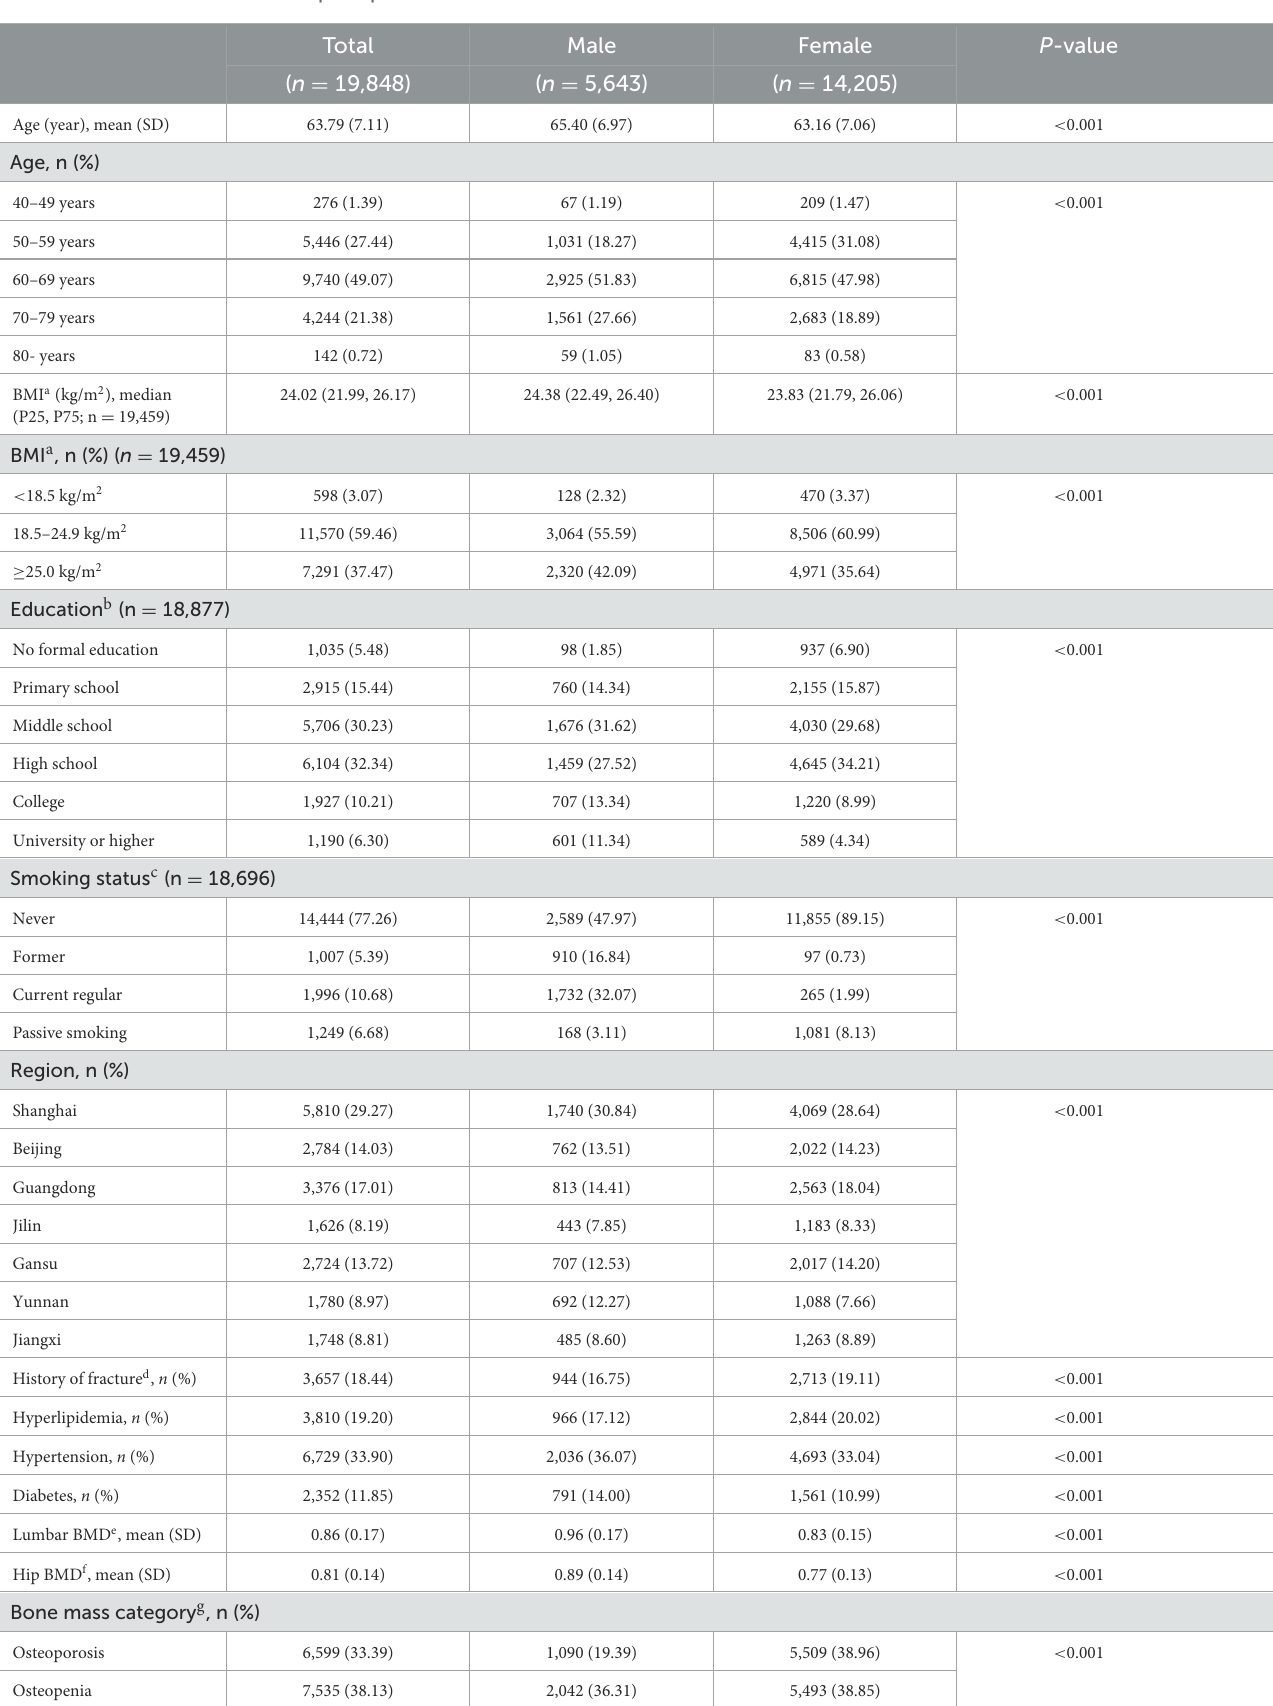
TABLE 1 General characteristics of the